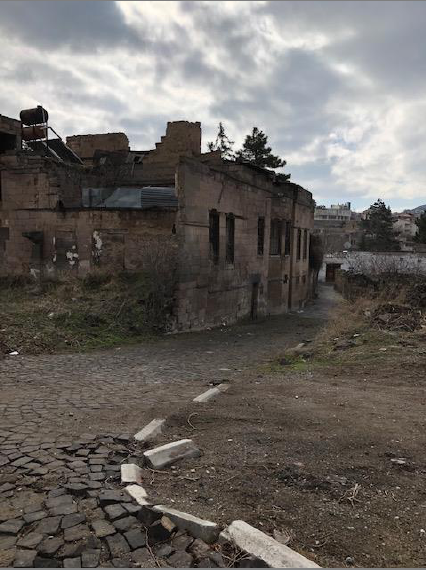
Figure 8 Gulbenkian mansion (Parlak Biçer,